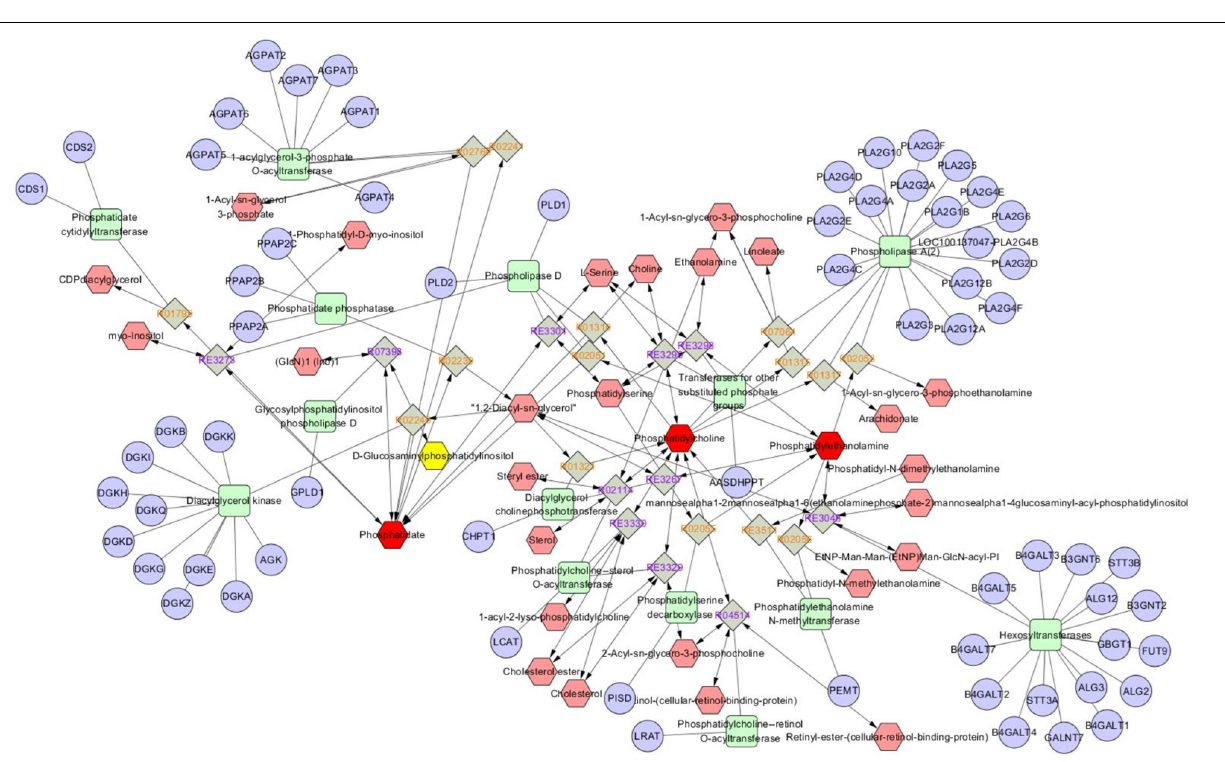
FIGURE 6 | Network of the remarkably perturbed metabolic pathways in IBD by MetScape analysis. The red hexagons indicate the differential lipid metabolites identified in our study. And the pink ones are the involved metabolites not been identified in our study. The significant changed metabolites ( p < 0.05) in IBD were shown as green line hexagons. The fold change of metabolites was indicated by hexagon’s